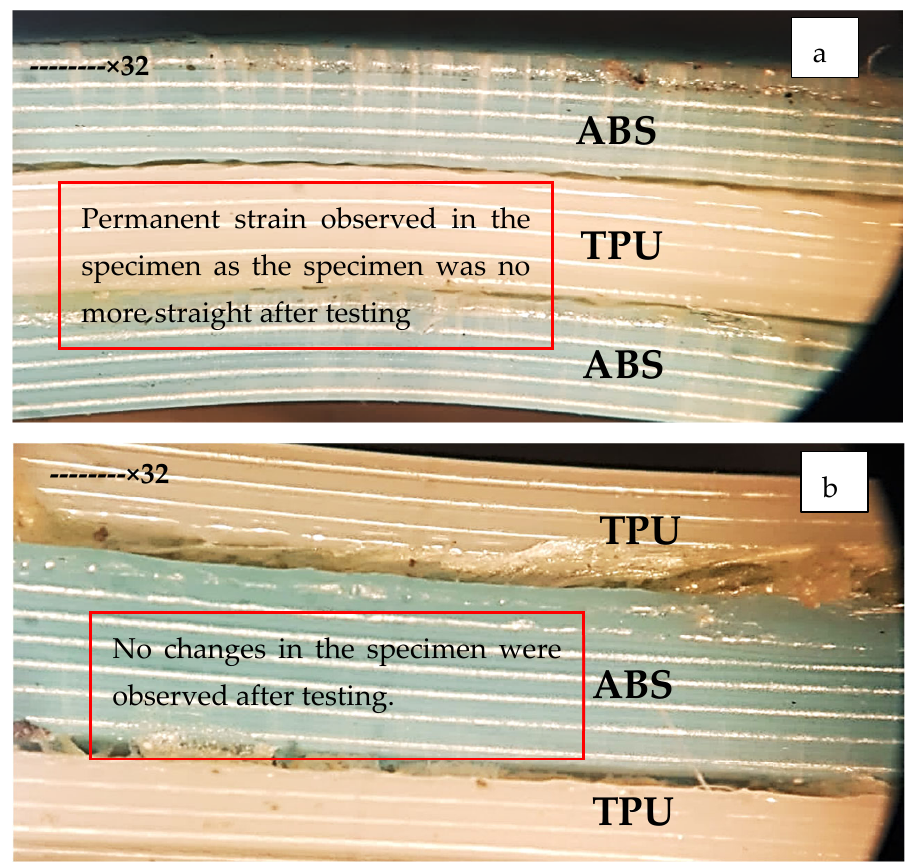
Figure 13. Tool Maker’s microscopic images of flexural tested specimen at ×32 for ( a ) sample 4 (ATA) and ( b ) sample 14 (TAT).